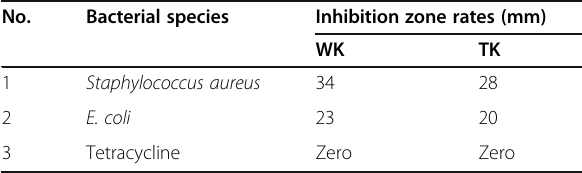
Table 6 Rates of inhibition zone diameters of WK and TK against bacterial clinical